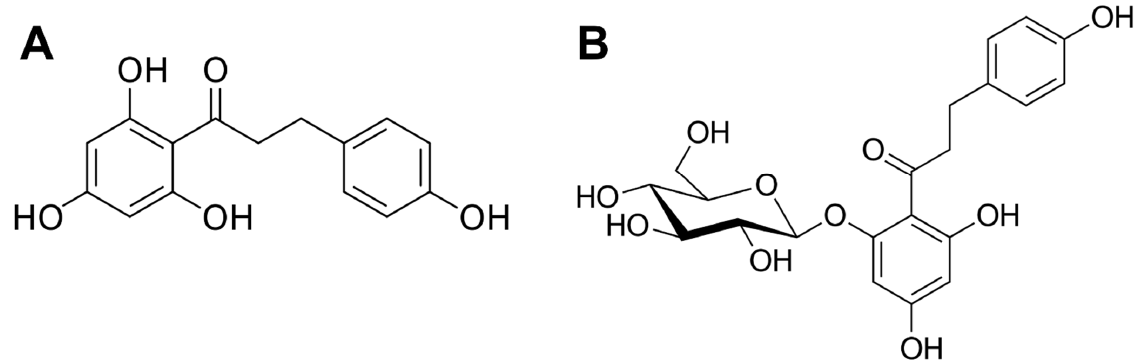
Figure 1. Chemical structures of phloretin ( A ) and phlorizin ( B ).